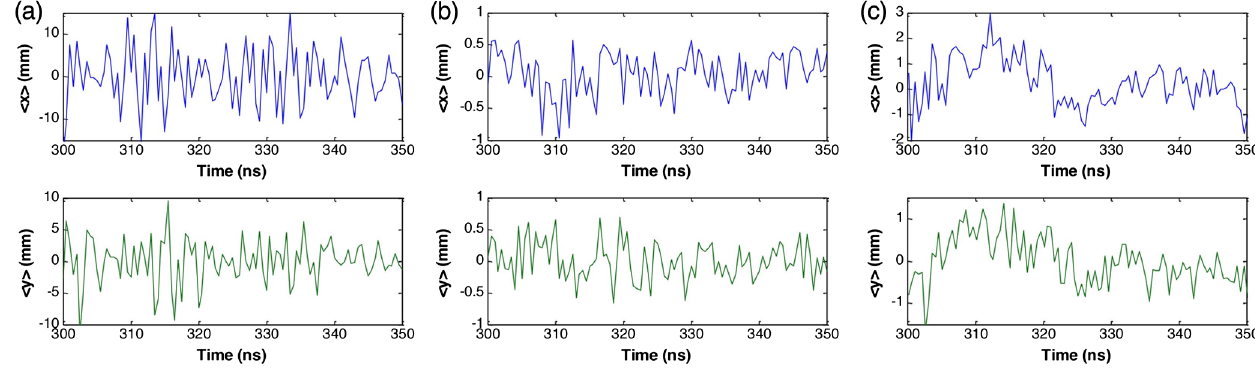
(green).FIG. 12. Comparison of the fluctuation of the beam distribution in x and y at BPM 22 ( z ¼ 37 . 8 m) for a single shot that represents the average case for five shots for (a) the initial 2.9 kA tune 4, (b) 1.7 kA tune, and (c) the final 2.9 kA tune (note scale